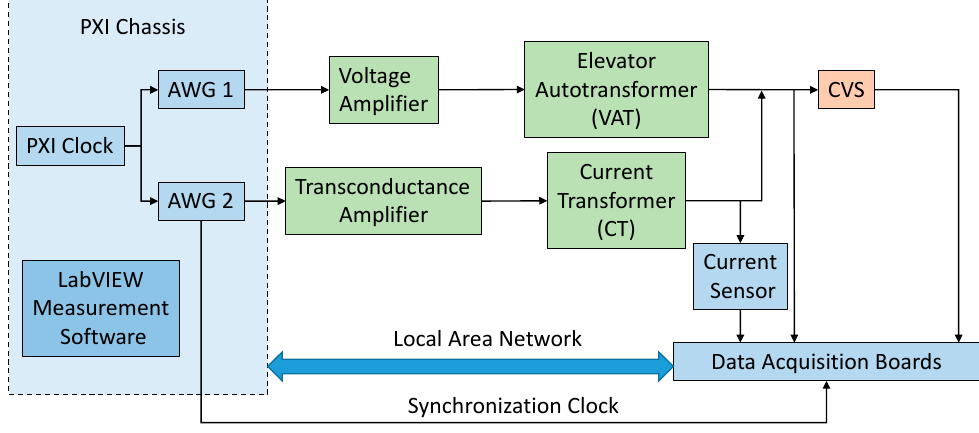
Figure 12. Block scheme of the measurement setup.